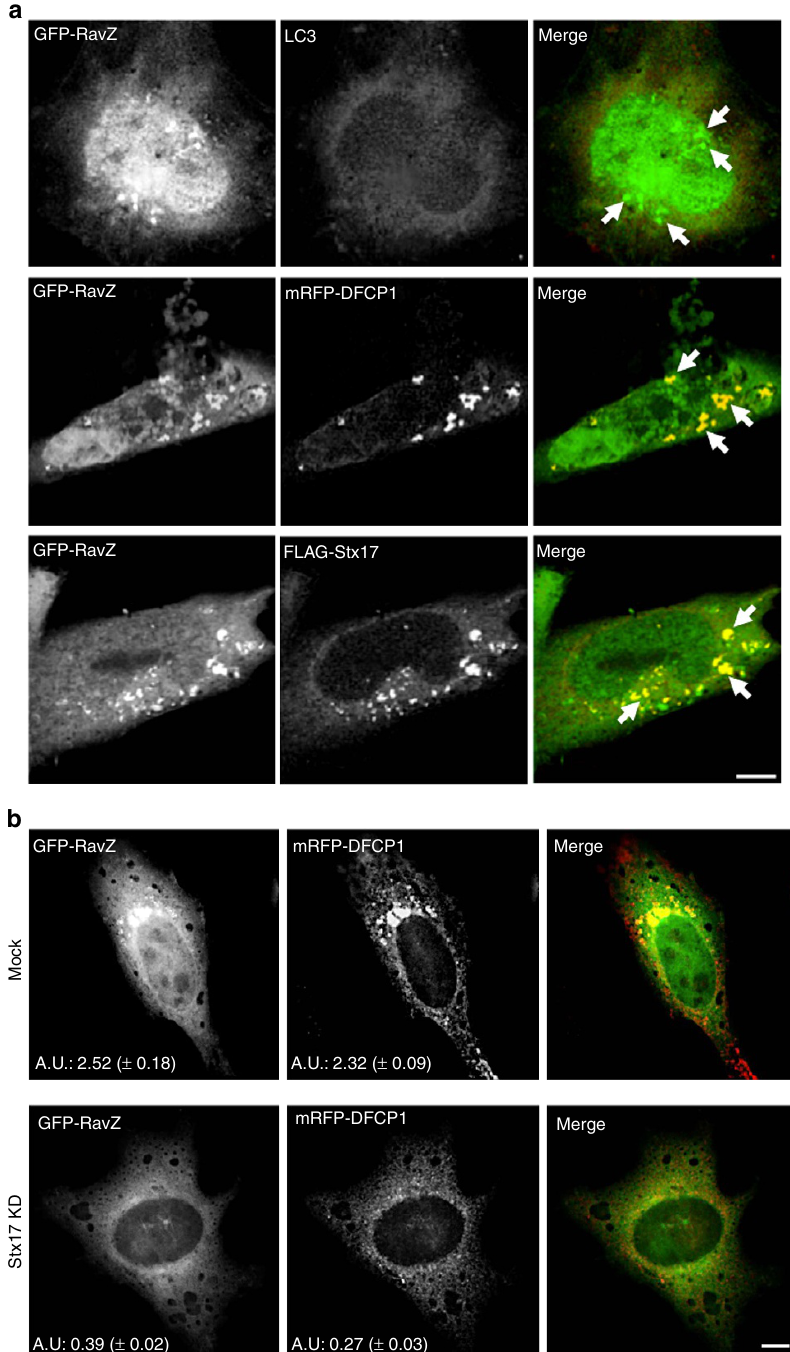
Figure 7 | RavZ-positive puncta are not formed on Stx17 depletion. ( a ) HeLa cells stably expressing Stx17 were transfected with a plasmid encoding GFP-RavZ (top and bottom rows) or both GFP-RavZ and mRFP-DFCP1 (middle row). At 24h after transfection, cells were incubated with EBSS for 2h, fixed and then stained with an antibody against LC3 (top low) or FLAG (bottom row). Arrows indicate representative GFP-RavZ-positive puncta. Scale bar, 5 m m. ( b ) HeLa-Fc g RII cells were transfected without (Mock) or with siRNA (Stx17 knockdown (KD)) targeting Stx17. At 48h after transfection, cells were transfected with plasmids encoding GFP-RavZ and mRFP-DFCP1. At 24h after transfection, cells were incubated with EBSS for 2h, fixed and observed by fluorescence microscopy. The numbers shown at the bottom of each panel indicate the intensity of GFP-RavZ or mRFP-DFCP1 staining in arbitrary unit (a.u.). Fifty cells expressing both GFP and mRFP were analysed in each experiment. Values are means ± s.d. ( n ¼ 3). P o 0.01 (GFP-RavZ) or P o 0.001 (mRFP-DFCP1). Scale bar, 5 m